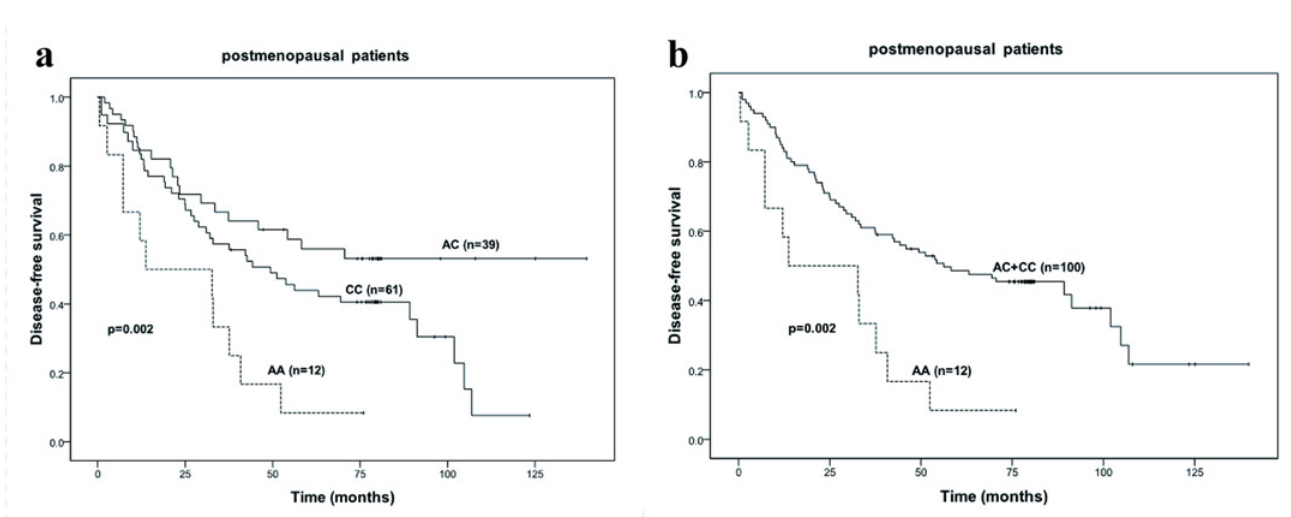
Fig 3. Survival curves for the postmenopausal patients. a. Disease-free survival of the postmenopausal women grouped by CYP19 rs4646 genotypes (CC vs AC vs AA). b. Disease-free survival of the postmenopausal women stratified by CYP19 rs4646 genotypes (AA vs AC + CC).